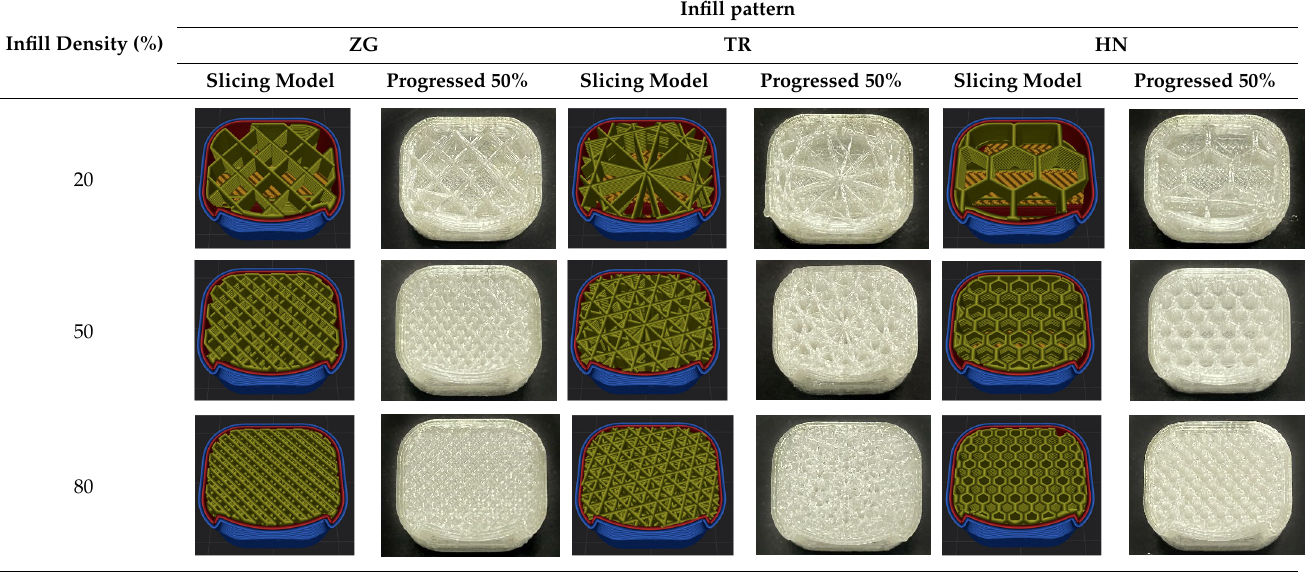
because of the low density. At 50% and 80% infill density, the unit increased approximately three times. And HN was deposited with the same hexagonal layers. As same tendency, Similarly, the number of units increased by more than three times as the density increased.